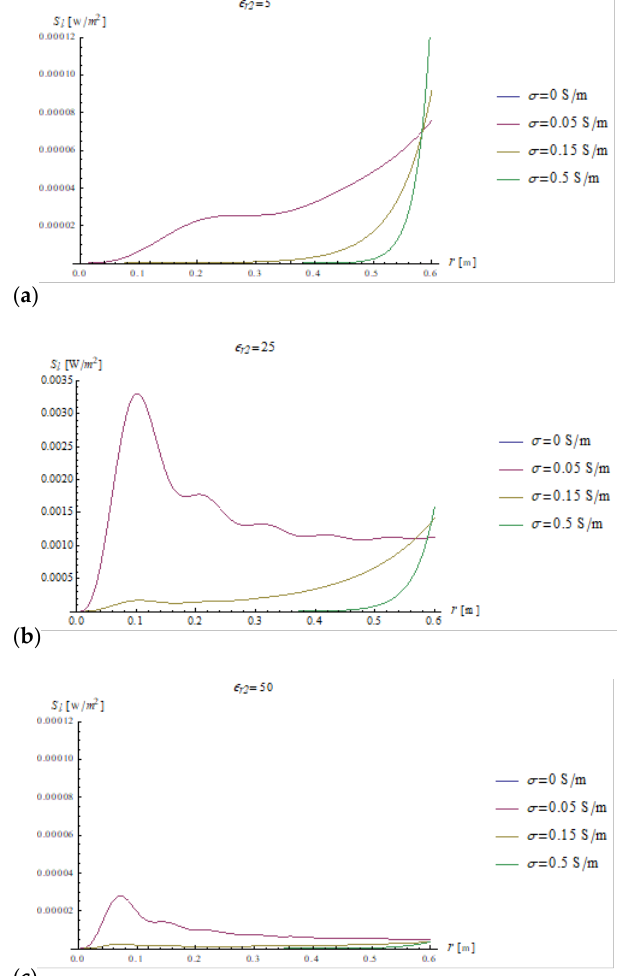
Figure 9. The amplitude is plotted as a function of the radial coordinate for different values of relative permittivity ( 𝜀 𝑟2 = 5, 25 and 50 in ( a – c ), respectively) and conductivity (see plot legend).